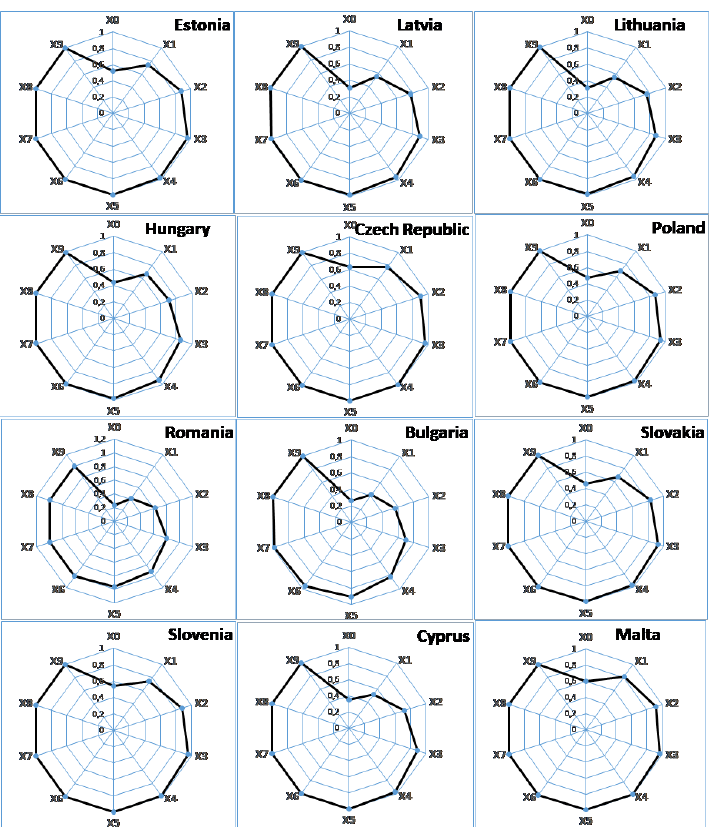
Figure 5. Presentation of the level of material deprivation in 2017. Source: own study based on